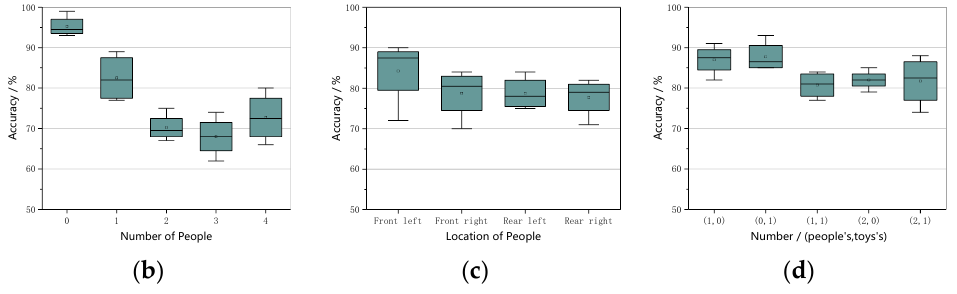
Figure 10. Accuracy of recognition of different categories: ( a ) different number of adults; ( b ) different number of children; ( c ) position when a single person; ( d ) comparison of persons and dolls.